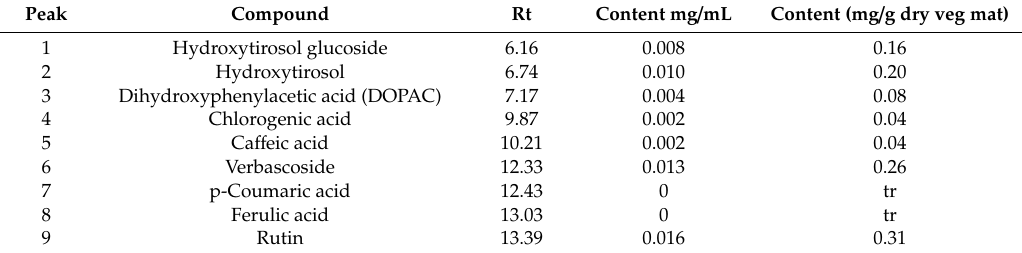
Table 1. Peak list and content of selected metabolites present in olive leaf extract (OLE). See text for details.